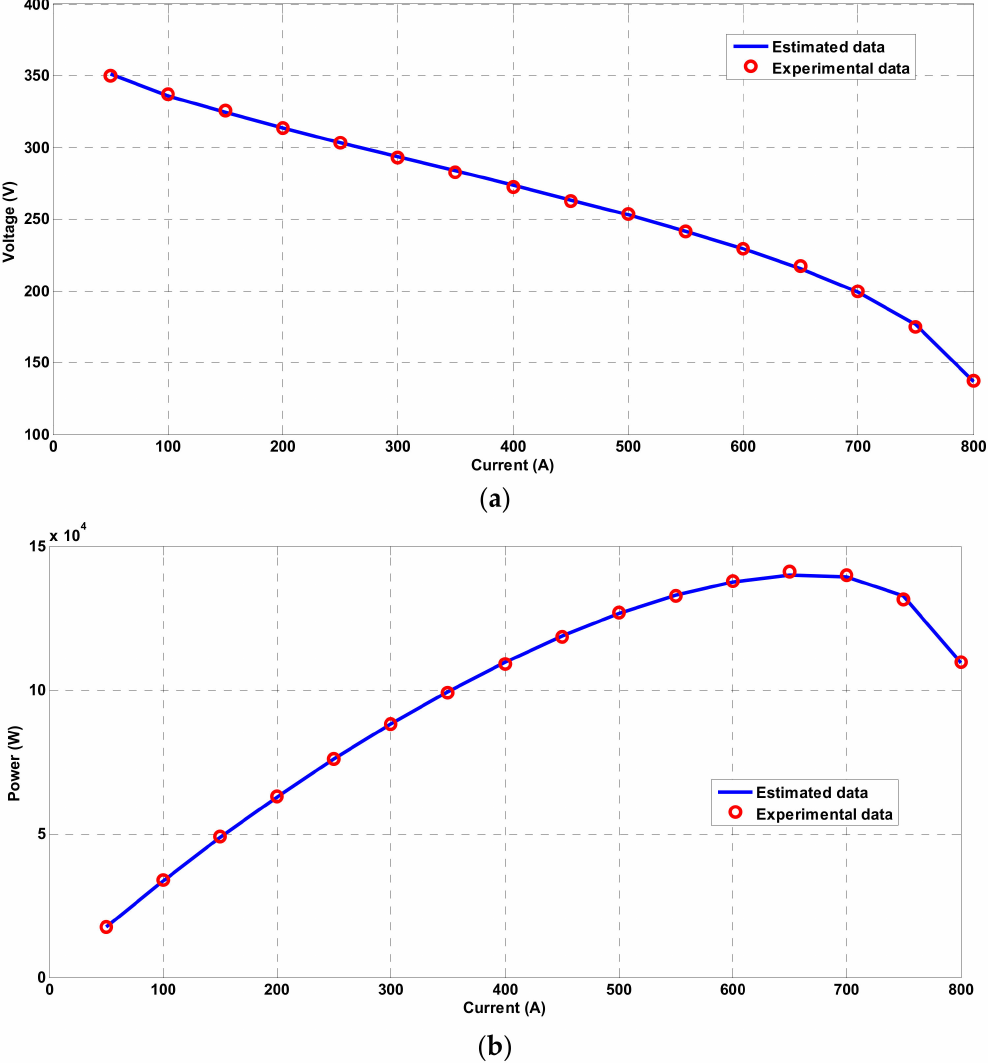
Figure 7. The measured and calculated polarization curves of SOFC dynamic-state model operated at 1273 K obtained via EO ( a ) current-voltage, ( b )